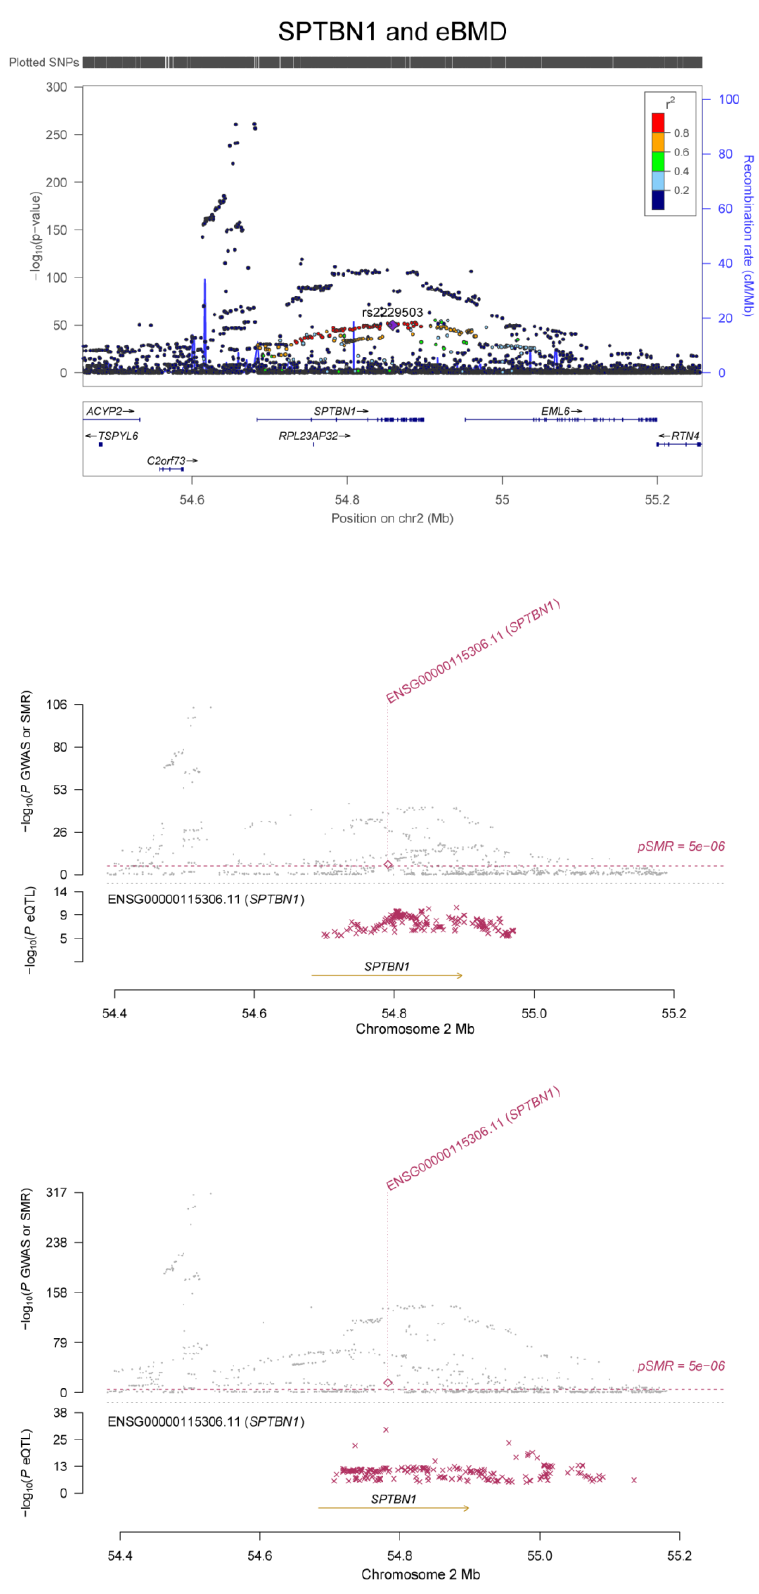
Figure 4. Association between the SPTBN1 gene and eBMD. The m 6 A-SNP rs2229503 in the SPTBN1 gene was associated with eBMD. The expression levels of the SPTBN1 gene in adipose tissue and whole blood were associated with eBMD.